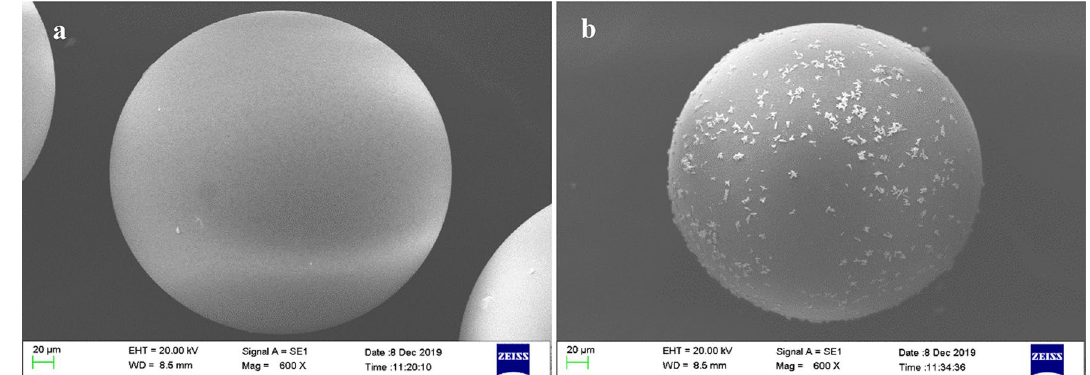
Figure 2. SEM image of A XAD-7 resin surface before ( a ) and after ( b ) impregnation with